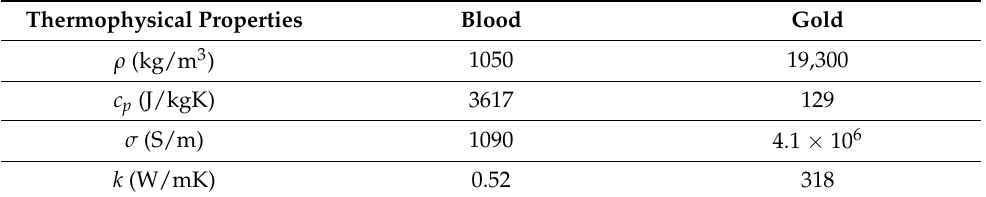
Table 1. Thermophysical properties of blood and gold nanoparticles (Koriko et al. [32]). Thermophysical Properties